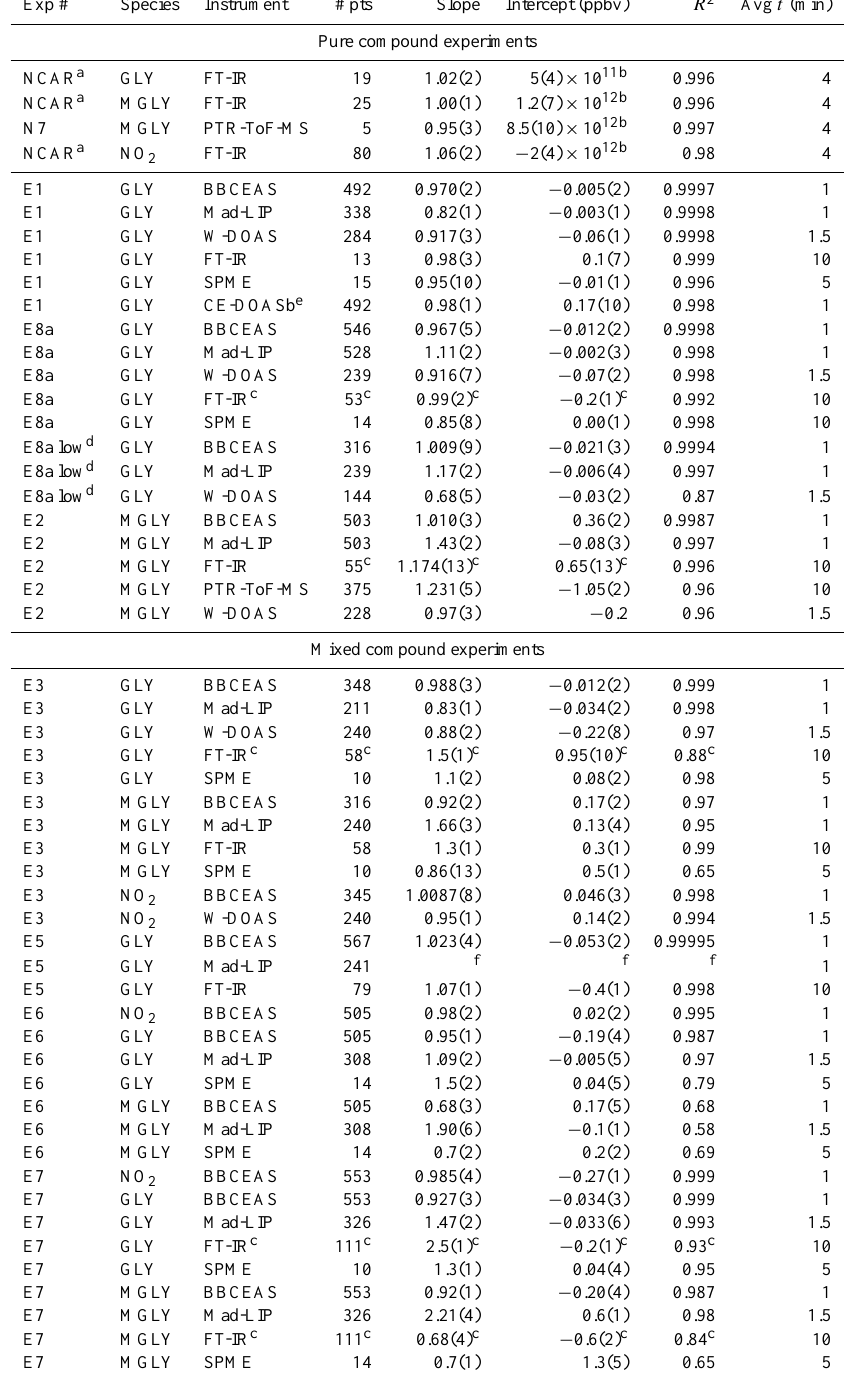
Table 3. Correlation data for instruments vs. CE-DOAS for individual